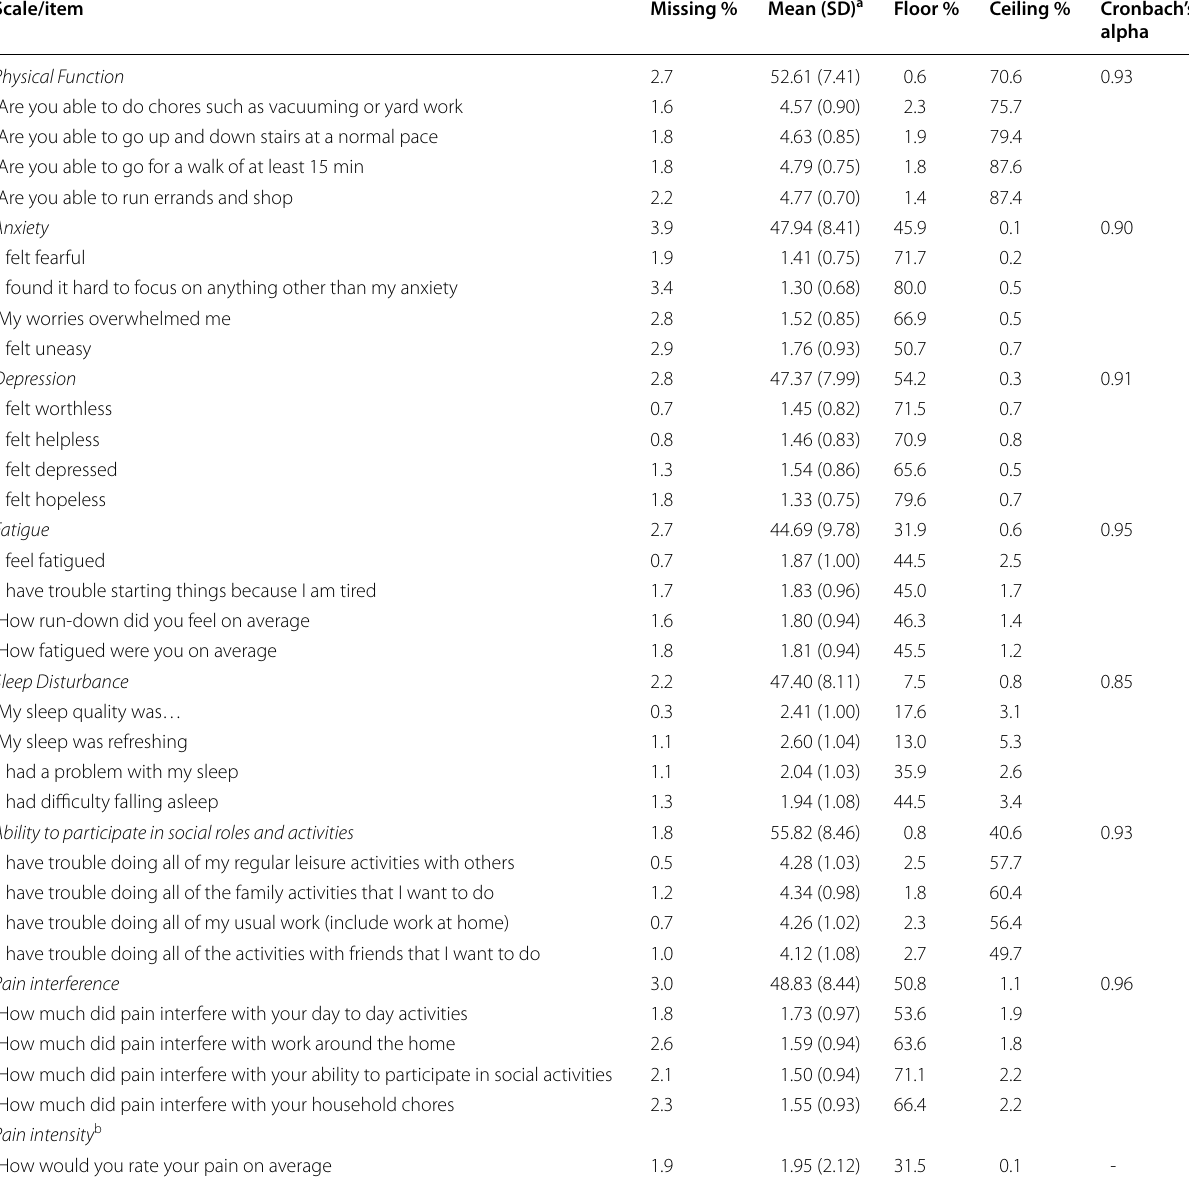
Table 2 Descriptives for PROMIS-29 items and domains, and reliability (Cronbach’s